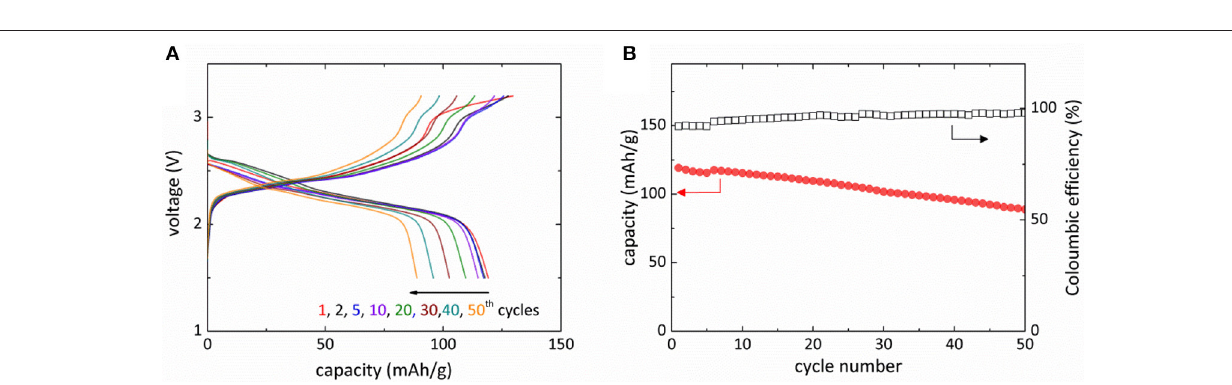
contribute to the shift of voltage profile. The appropriate